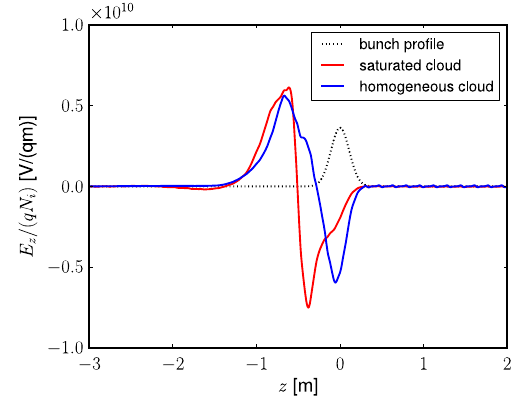
FIG. 9. The longitudinal electric field obtained from the 2D simulations induced by a LHC bunch in the saturated cloud and in the corresponding homogeneous cloud ( n e (cid:3) 10 13 m (cid:2) 3 ). Shown is the electric field induced by the lower bunch in Fig.